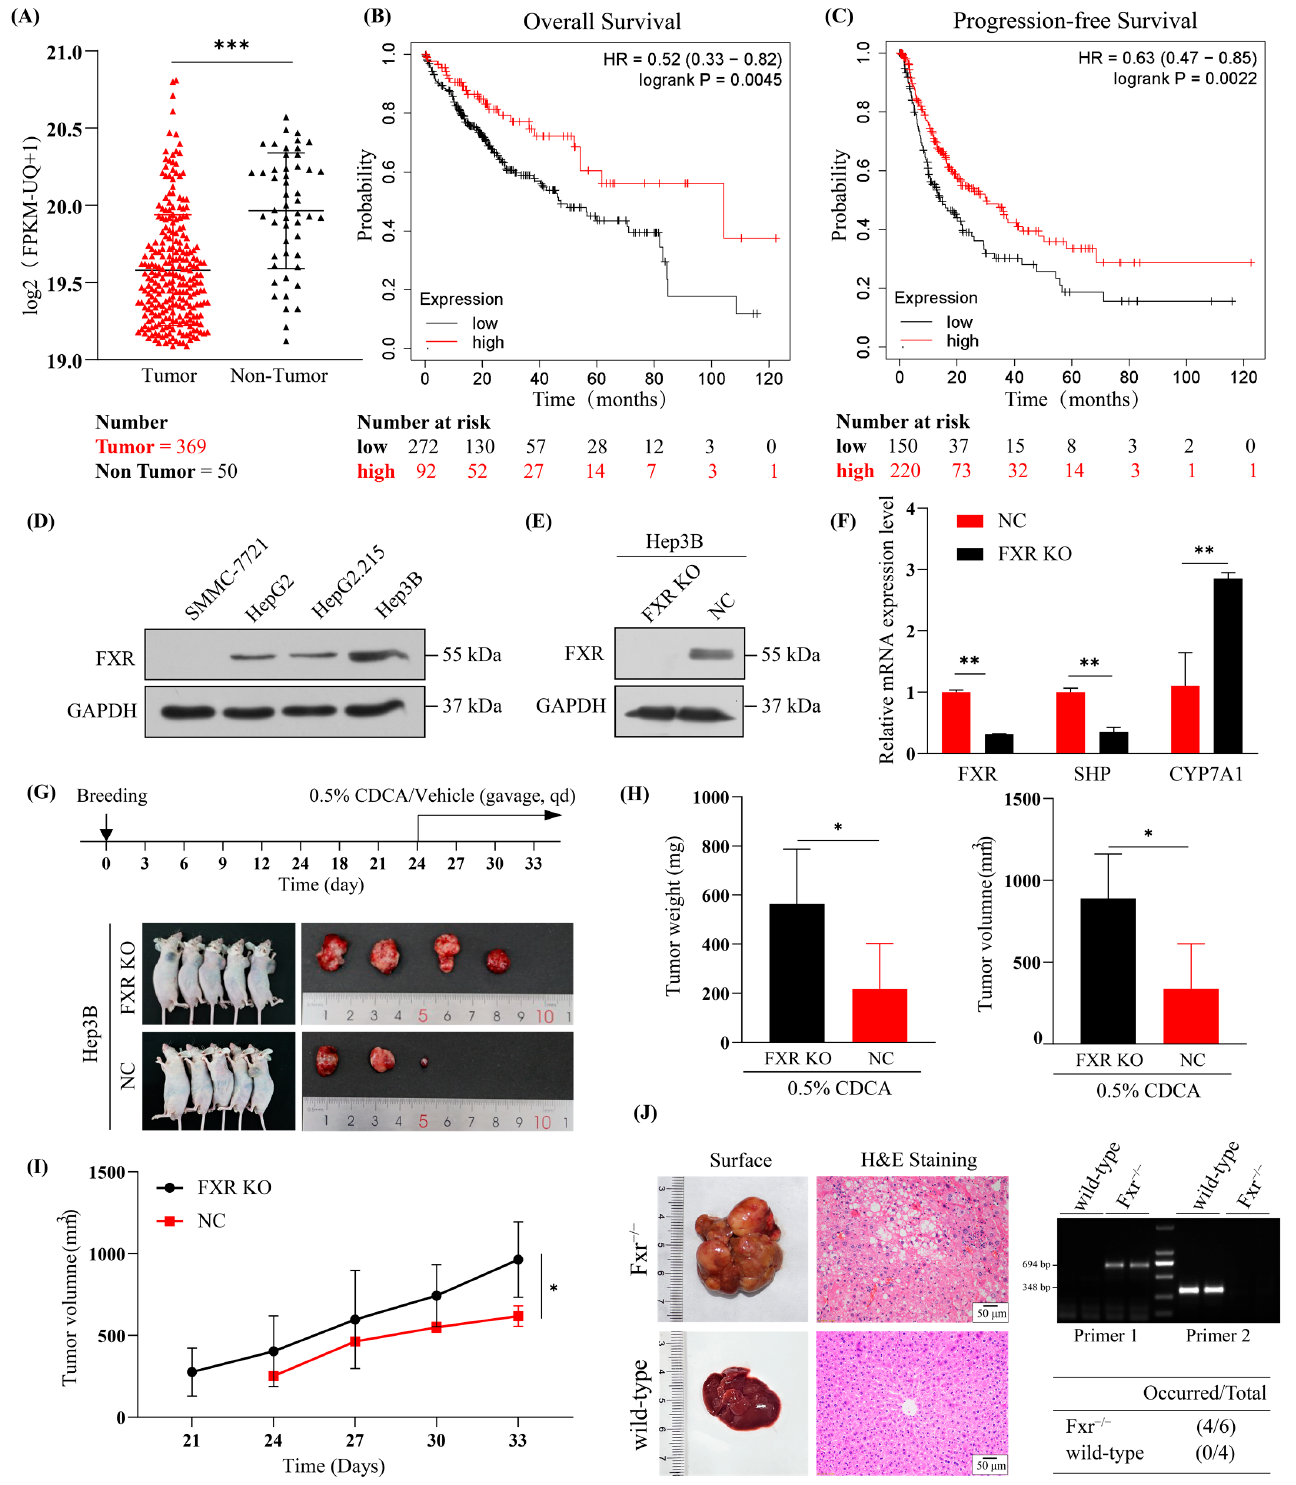
Figure 1. Low FXR expression correlates with poor prognosis in HBV-related HCC and FXR KO promotes liver tumorigenesis. ( A ) The differences in FXR mRNA expression levels between normal ( n = 50) and liver cancerous tissues ( n = 369) in TCGA. ( B , C ) are Kaplan-Meier analyses of 153 HBV- related HCC patients regarding OS and PFS with high and low FXR expression. ( D ) Expression of FXR in SMMC-7721, HepG2, HepG2.215, and Hep3B cells. ( E , F ) Effect of FXR knockout on the expression of downstream FXR target genes of FXR, SHP, and CYP7A1, as examined by western blotting and